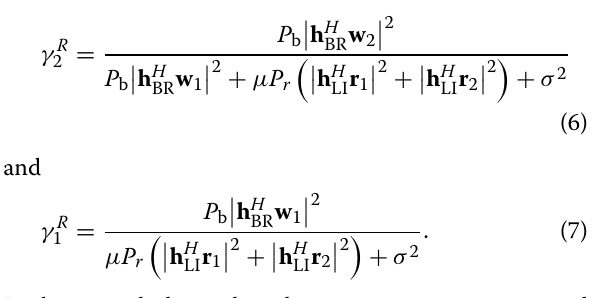
After receiving the superimposed signal from the